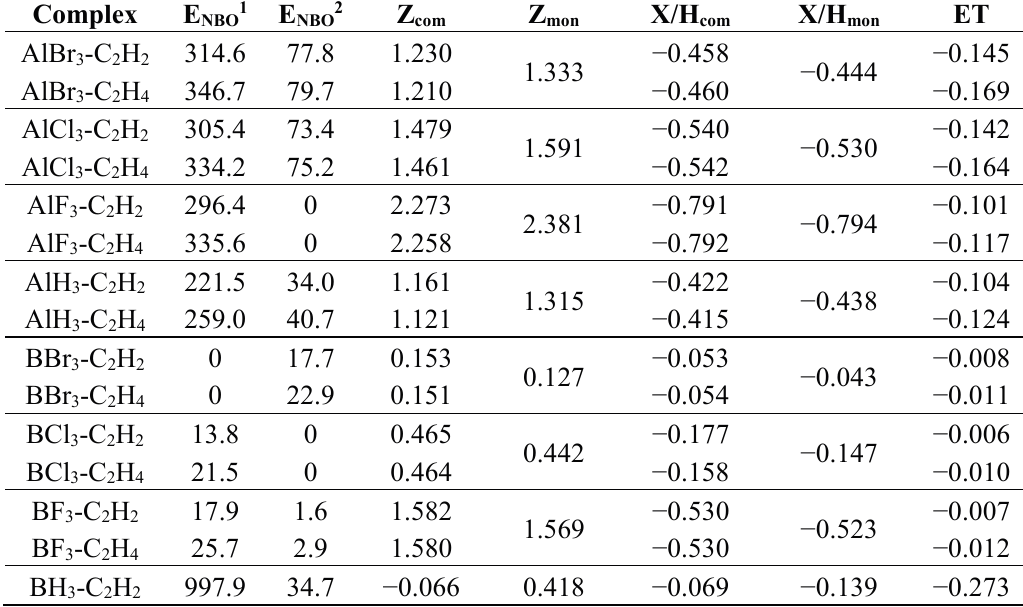
Table 3. The NBO charges of Z and X (or H) atoms in monomers and in complexes, ET—Electron charge transfer (values in au), E NBO1 and E NBO2 energies (in